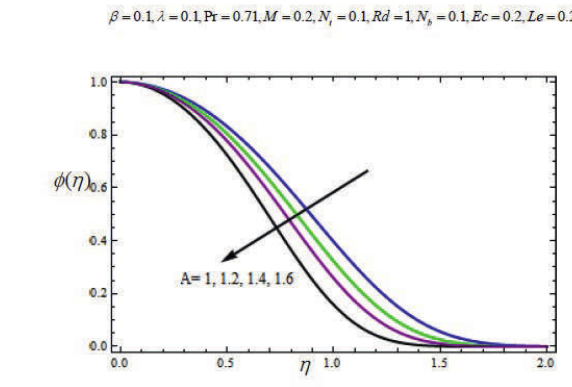
Fig. 21: Variation of nanoparticle concentration with η for several values of Heat parameter A .